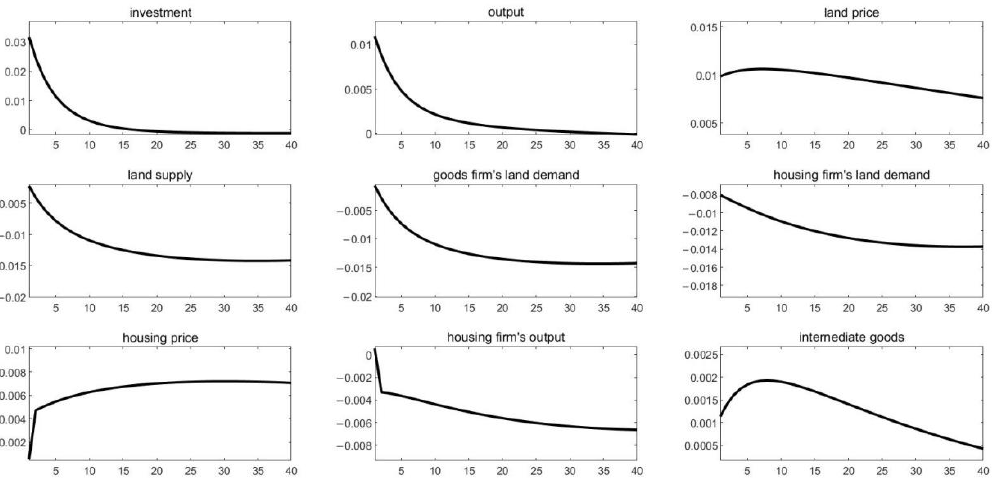
Figure 4. Impulse responses to a positive (one standard deviation) TFP shock (endogenous land, γ < 1).